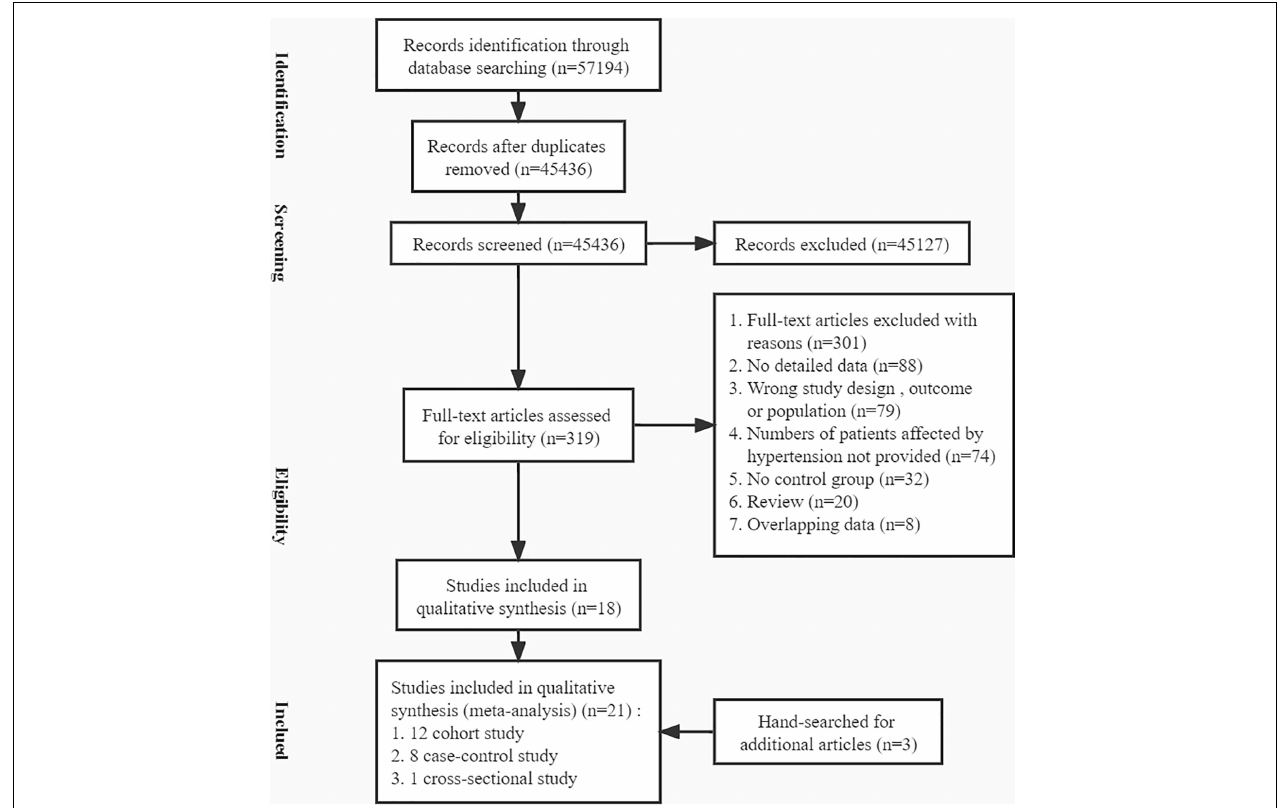
FIGURE 1 | A flow chart of the screening of studies on HDP/GH/PE and chronic hypertension.